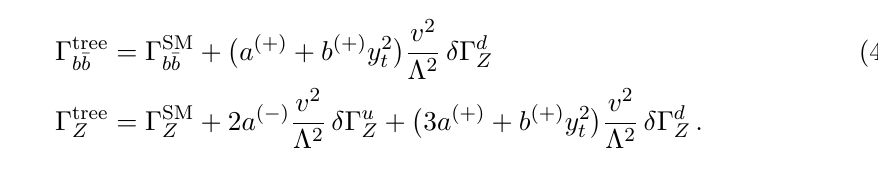
Figure 2 . Illustration of two different insertions of four-quark SMEFT operators in Z → b s -channel topology, with insertion of ( C ( − ) qq ) 3333 . Right: t -channel topology, involving a charged current with insertion of ( C (3) ) . The operator insertion is illustrated by two filled squares, each qq 3333 indicating a quark